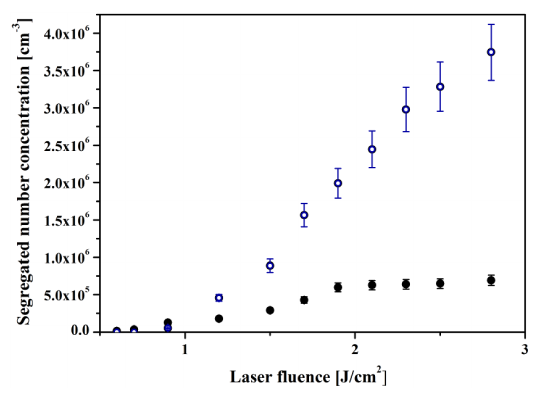
Figure 4. Segregated number concentrations in the two characteris- tic modes as a function of the laser fluence. Closed circles: primary particles, open circles: fractal aggregates. The error bar represents the standard deviation of the measured data including concentration and instrument